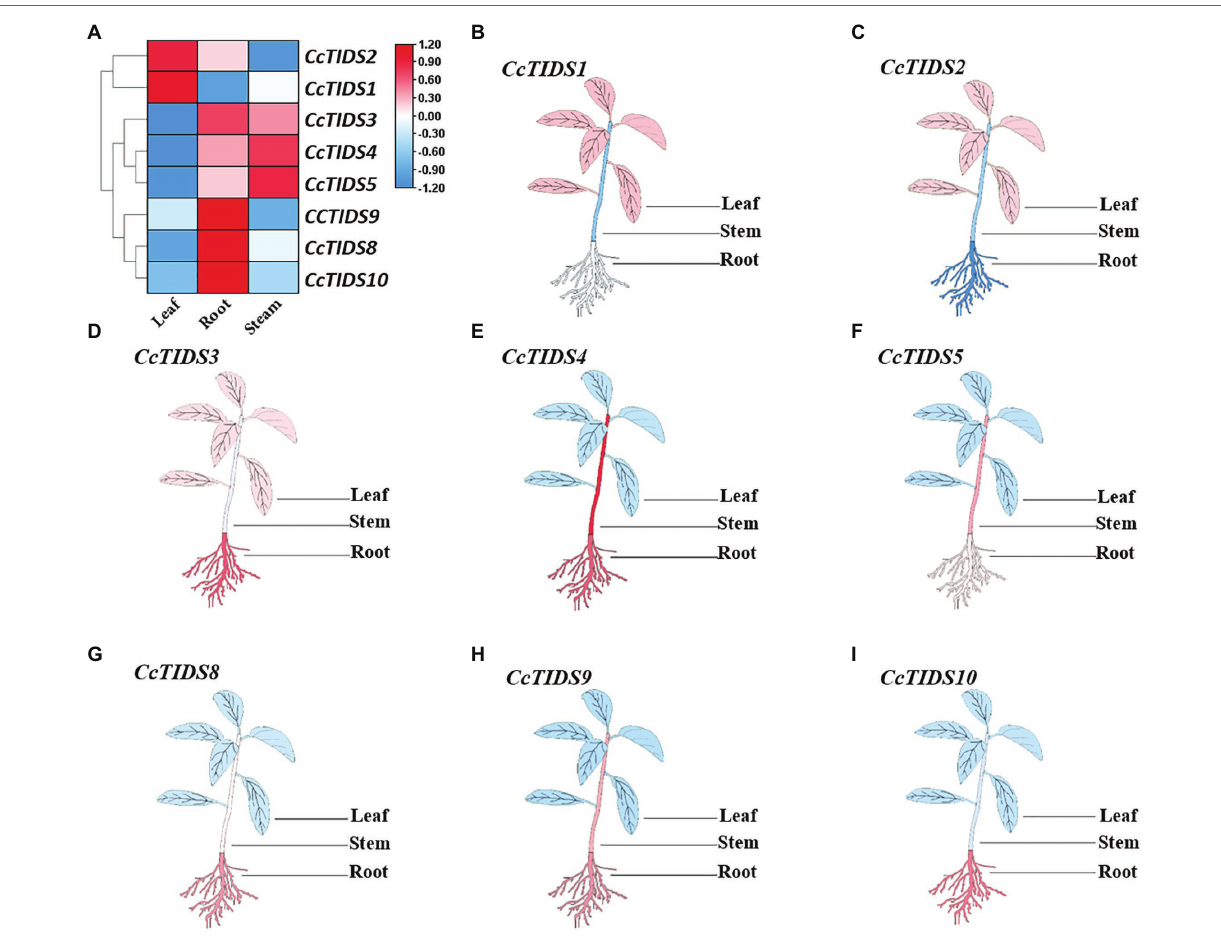
FIGURE 5 | Differential expression of C. camphora (Cc)TIDS genes in different tissues by transcriptome and quantitative real-time PCR (qRT-PCR). (A) FPKM value of the RNA sequencing data for each gene in leaf, root, and stem tissues. (B–I) Relative expression of each gene in the different plant tissues as calculated by qRT- PCR, with red and blue representing high and low expression levels,